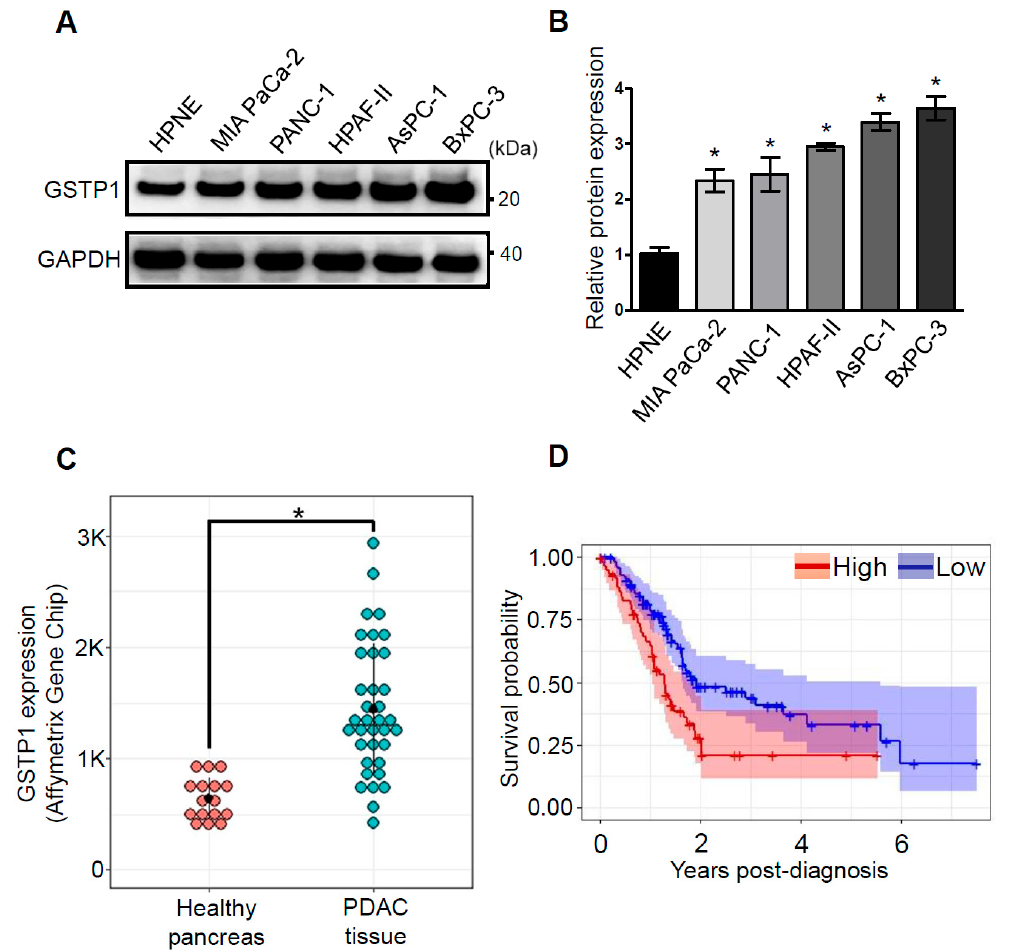
Figure 1. Glutathione S-transferase pi-1 (GSTP1) is overexpressed in human pancreatic